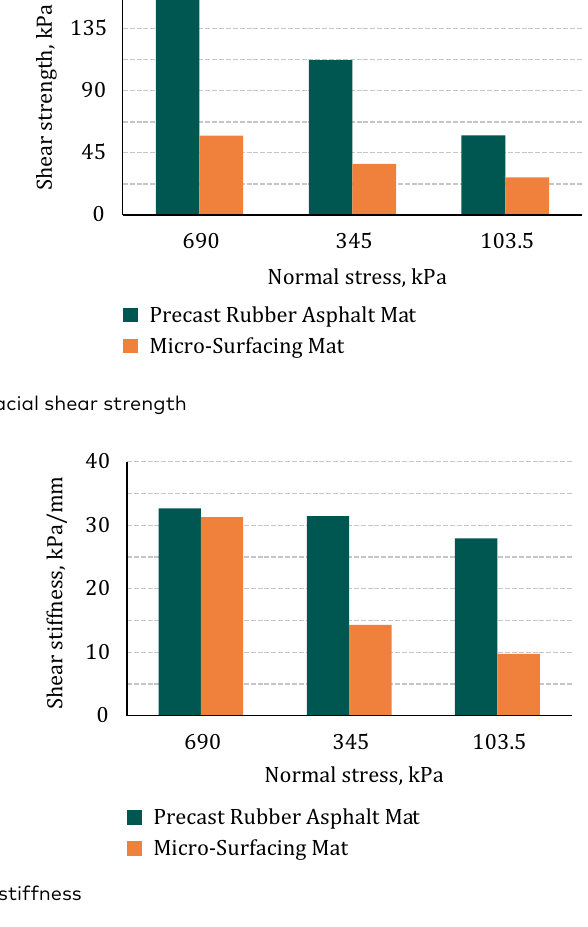
Figure 8. Shear strength and stiffness under various normal